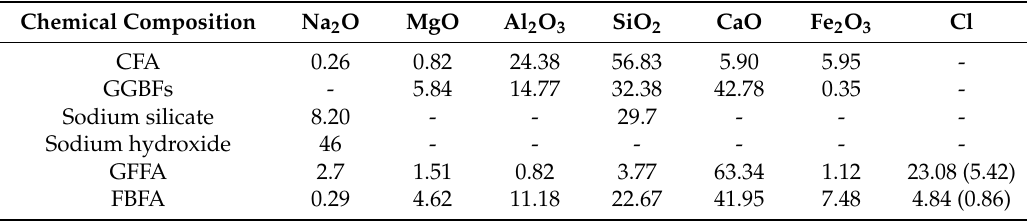
Table 1. The chemical compositions of raw materials ( wt %).